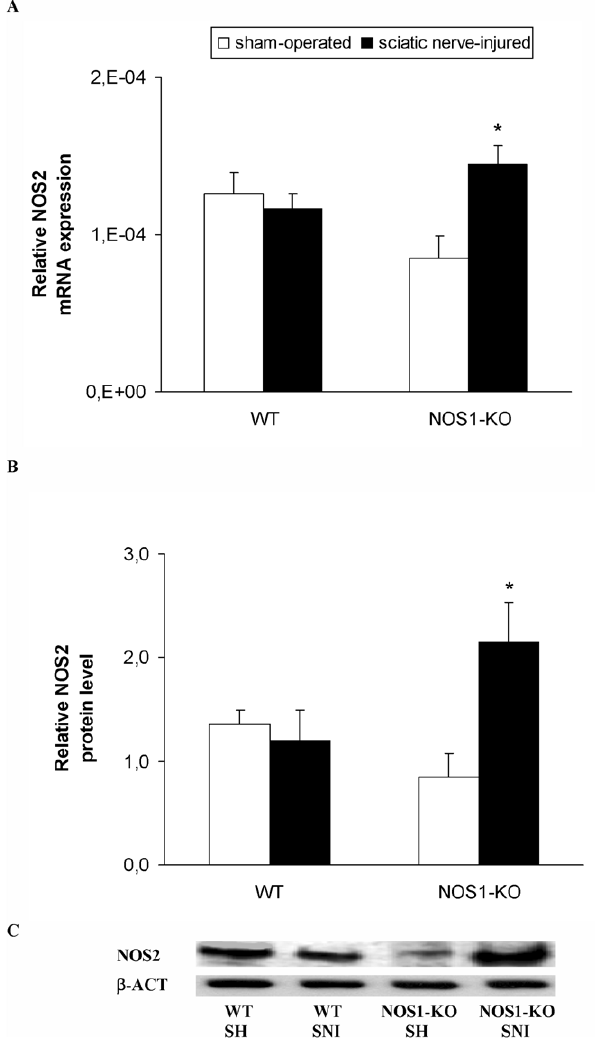
Figure 3. Spinal cord expression of NOS2 in WT and NOS1-KO mice. The relative NOS2 mRNA ( A ) and protein ( B ) expression in the ipsilateral site of the lumbar section of the spinal cord from sham- operated (SH) and sciatic nerve-injured (SNI) WT and NOS1-KO mice at 21 days after sciatic nerve ligation are represented. In both figures, * indicates significant differences when compared sciatic nerve-injured NOS1-KO mice vs. sham-operated NOS1-KO animals (* p , 0.05, one-way ANOVA followed by Student-Newman-Keuls test). A representative example of Western blots for NOS2 protein (130 kDa) in which b -actin (43 kDa) was used as a loading control is shown in C . Data are expressed as mean values 6 SEM; n=4–5 samples per group.